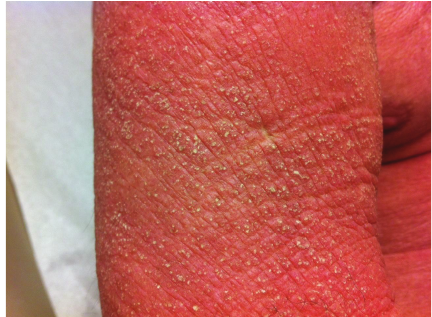
Figure1:Cutaneousmucinosis: violaceous, scaly, anderythematous rash of the right arm.